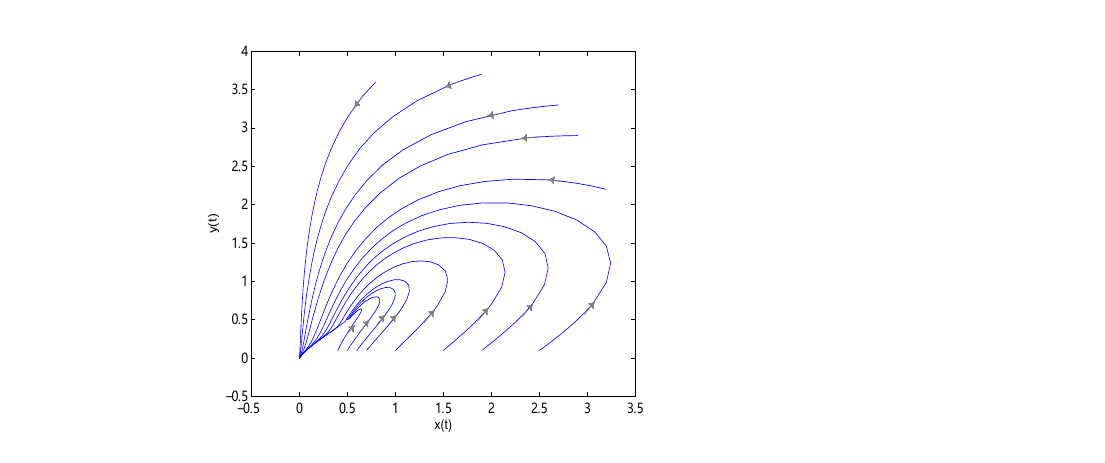
Figure 13. O is globally asymptotically stable. A 4 (0.5, 0.5) is a saddle node. In here r = 1.5, ω = 1, b = 0.5, c = 1, α = 1.